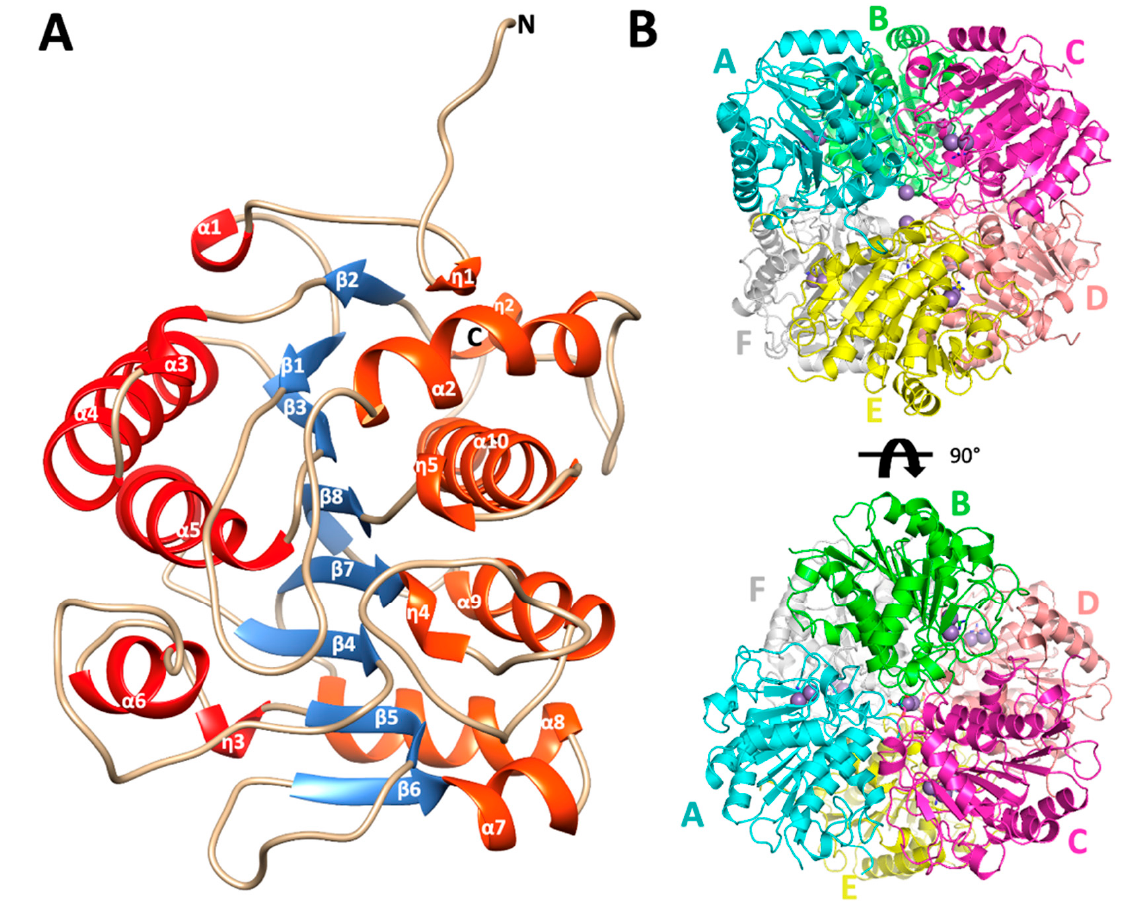
Figure 2. Monomer architecture and quaternary structure of Escherichia coli agmatinase . ( A ) The overall structure of the monomer of EcAGM. The eight central β strands are represented in blue. In red and orange have been represented both sides of helices that connect the β sheet. ( B ) quaternary structure of EcAGM, each monomer is labeled with letters from A to F. The arrangement of a dimer of trimers (ABC and DEF) in the hexamer is shown.